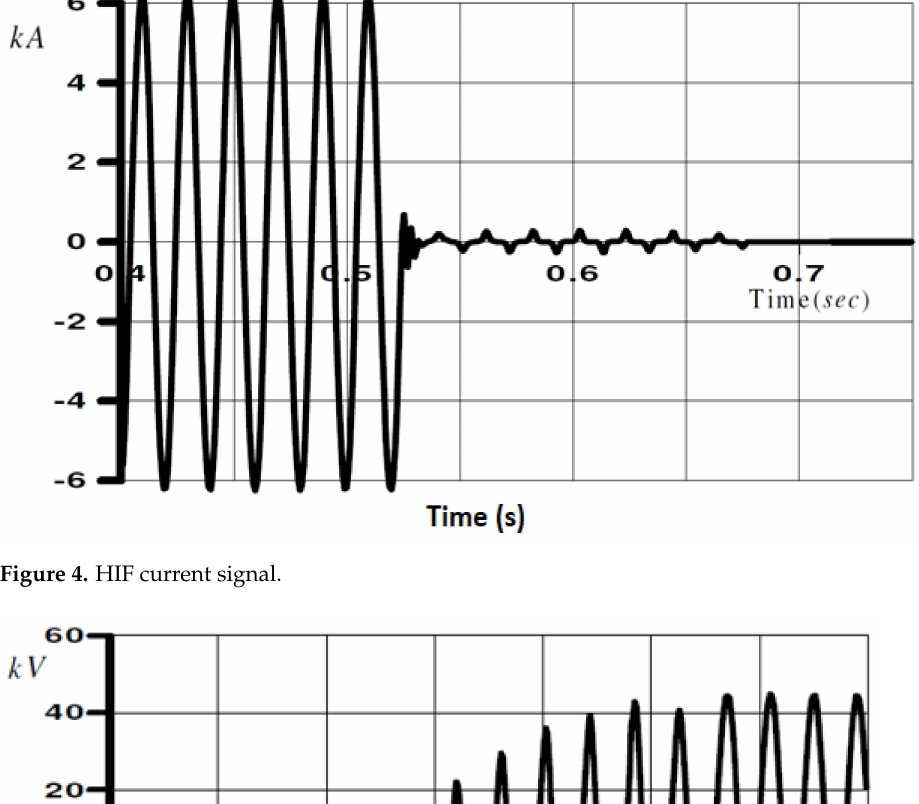
Figure 4. HIF current signal.